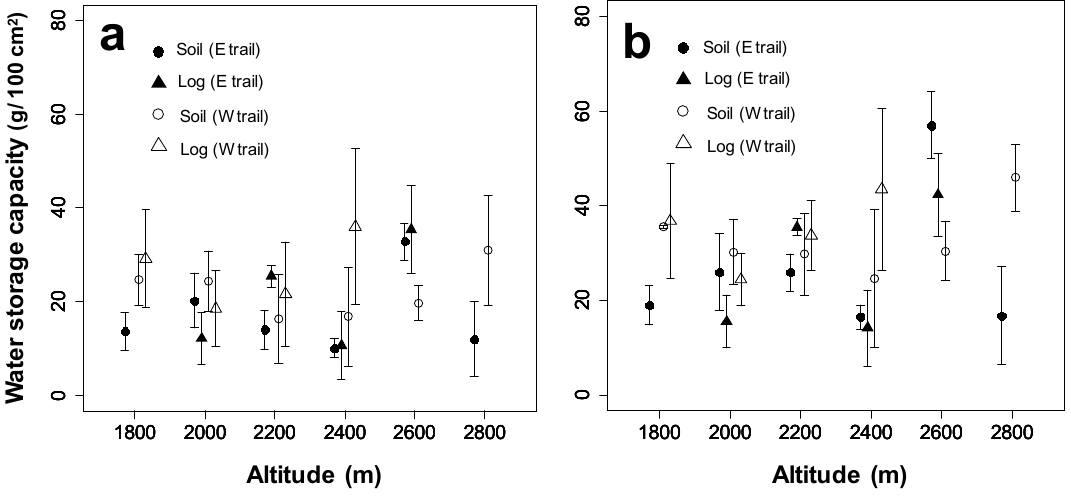
Figure 3. Changes to the water storage capacity of bryophyte communities at the quadrat scale with respect to altitude: ( a ) fresh samples and ( b ) dry samples; the error bar indicates standard deviation.